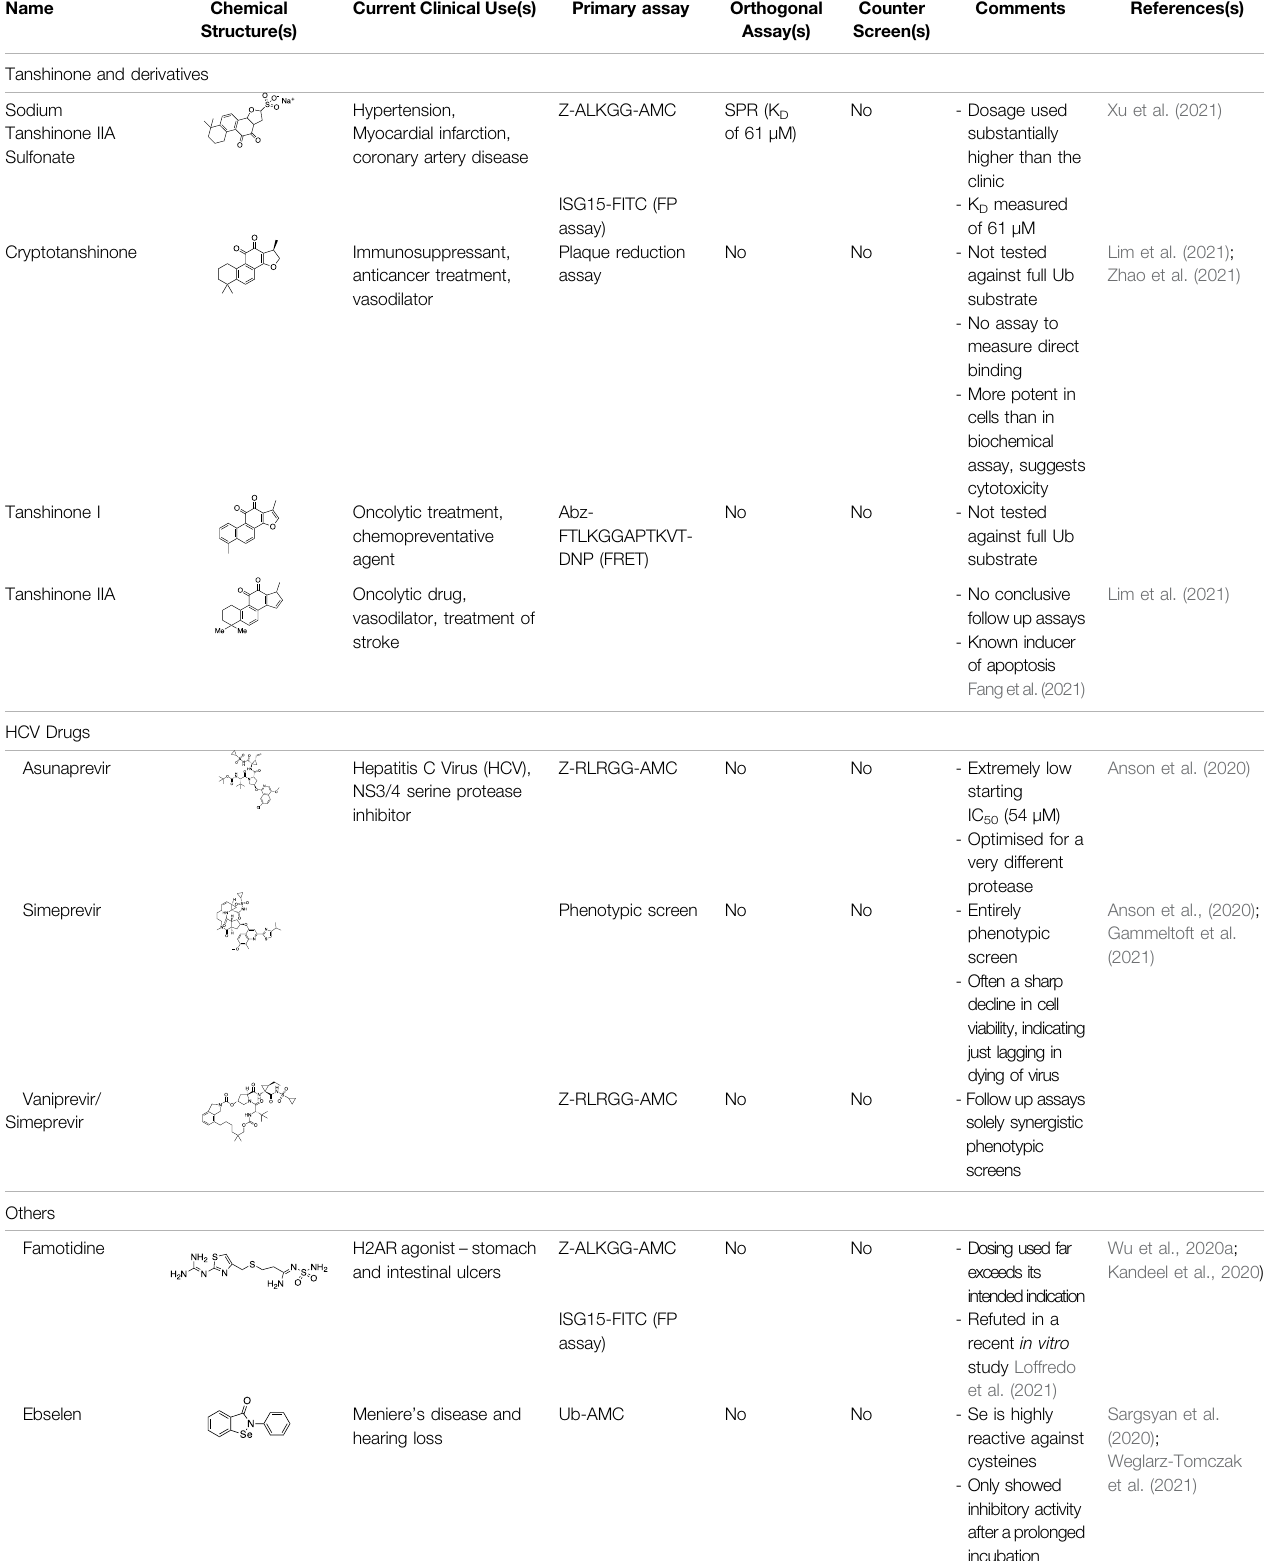
TABLE 1 | Summary of reported drug repurposing attempts against SARS-CoV-2